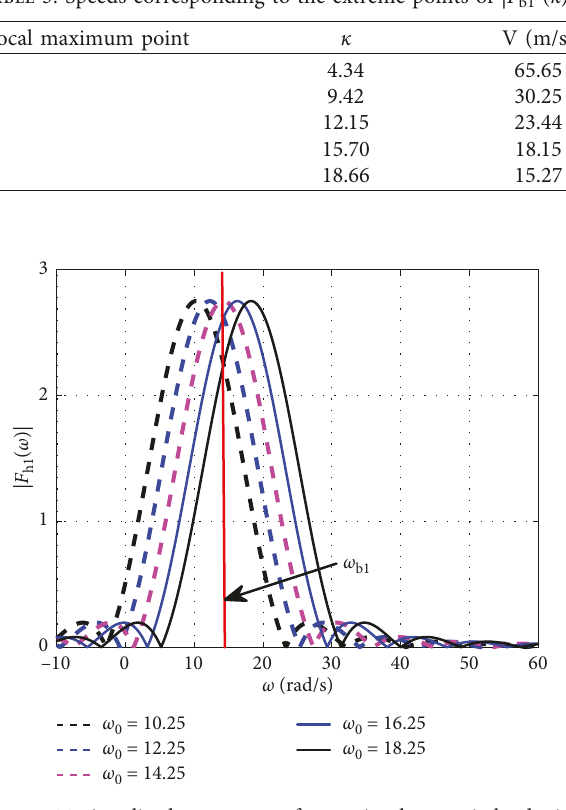
Figure 11: Amplitude spectrum of a moving harmonic load with different frequencies ω 0